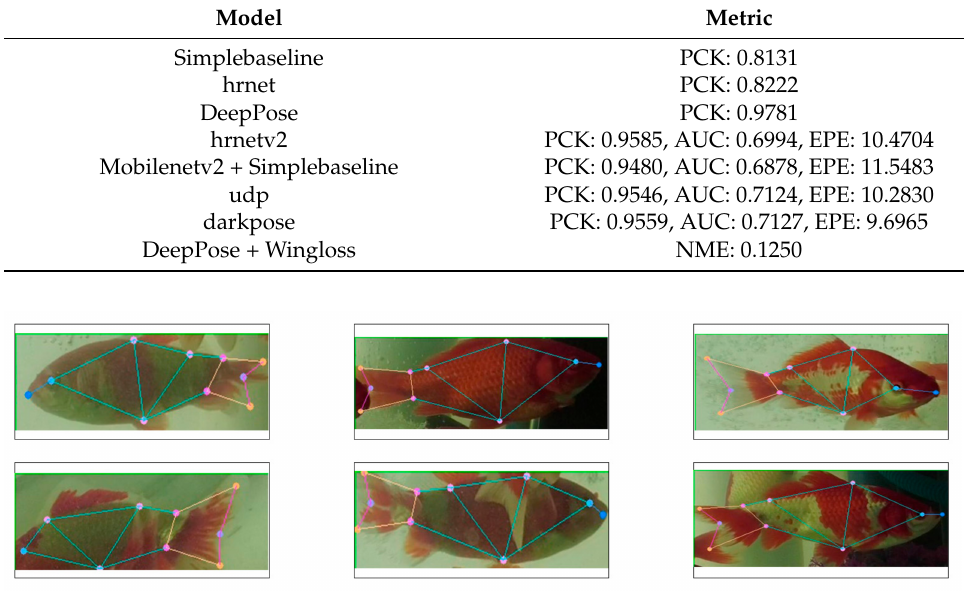
Figure 14. The metrics of each model changed during training. Table 4. Pose estimation model comparison.